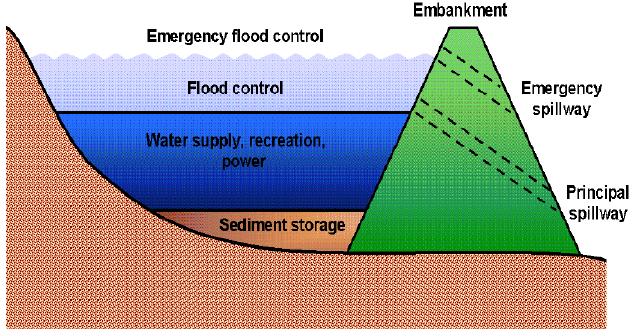
Figure 2. Components of a reservoir with flood water detention features [36].